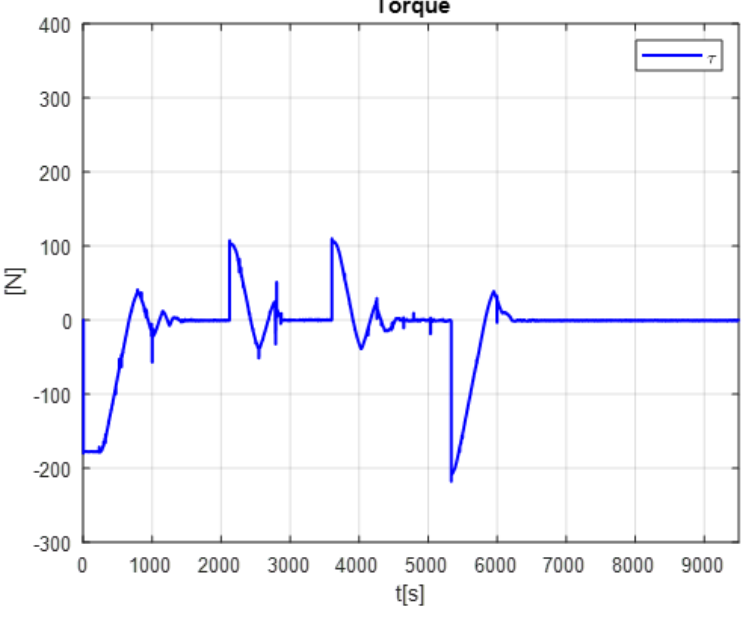
Figure 18. Self tuning control with